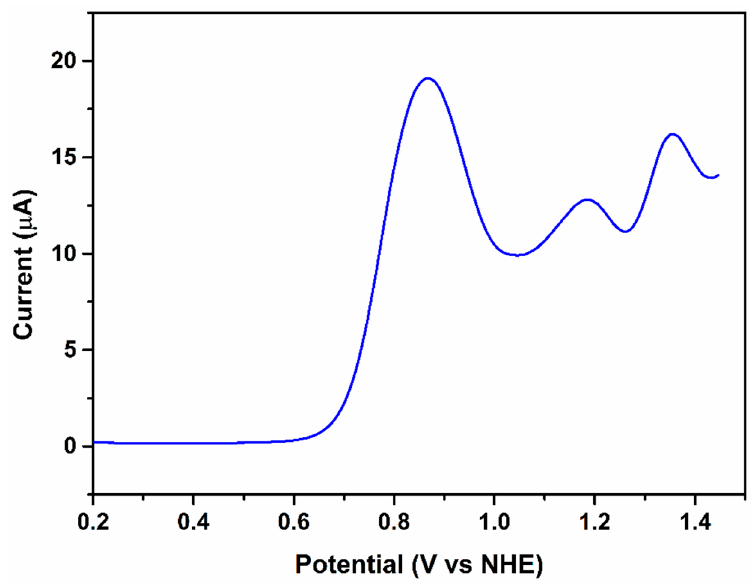
Figure 6. Square wave voltammogram of a solution containing 1.0 mM Na 3 [Ru 2 (µ-CO 3 ) 4 ] in the presence of 0.10 M NaHCO 3 , pH 8.3, under N 2 atmosphere. Instrumental settings: Amplitude, 0.010 V; frequency, 15.0 Hz.